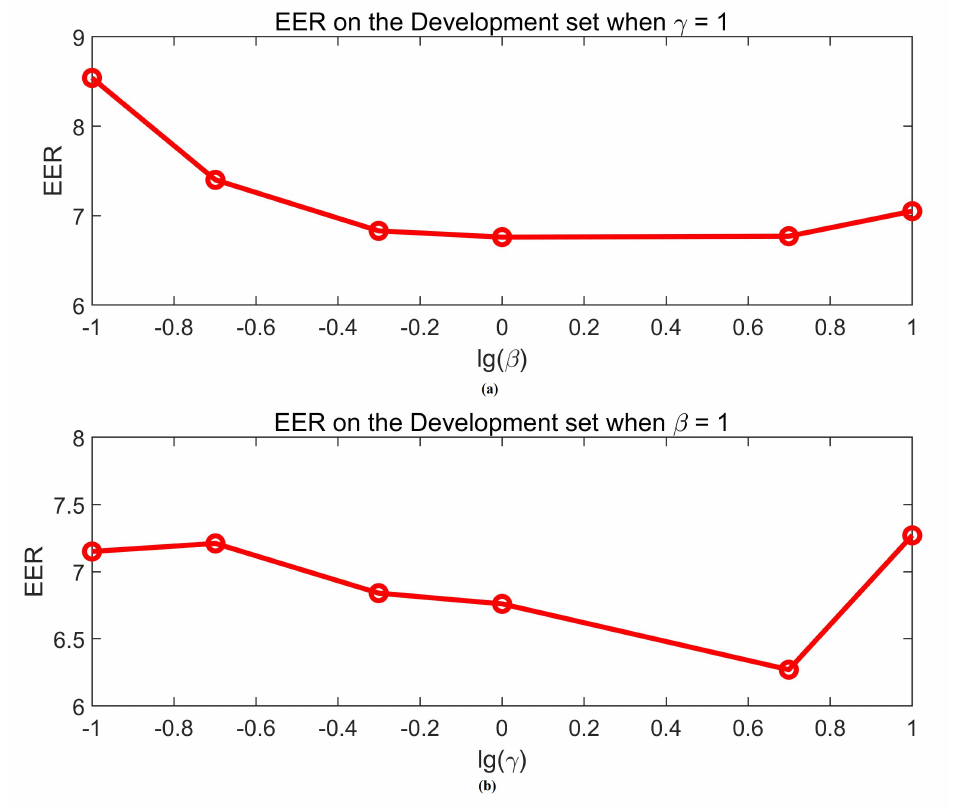
Figure 5. The equal error rate ( EER ) corresponding to different weights of losses. ( a ) the EER on the development set when γ = 1; ( b ) the EER on the development set when β =